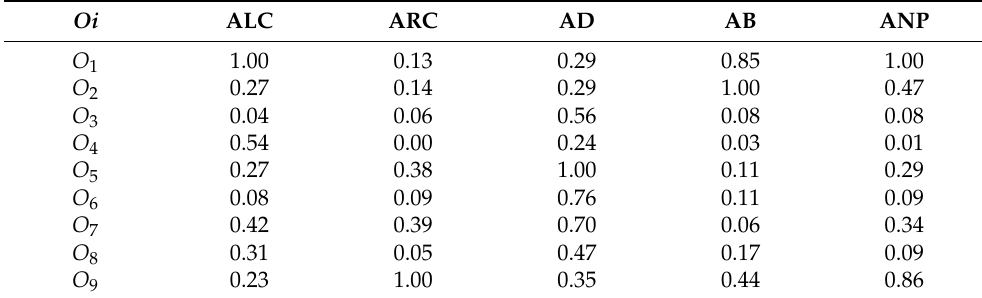
Table 19. Decision matrix for traditional ELECTRE II.